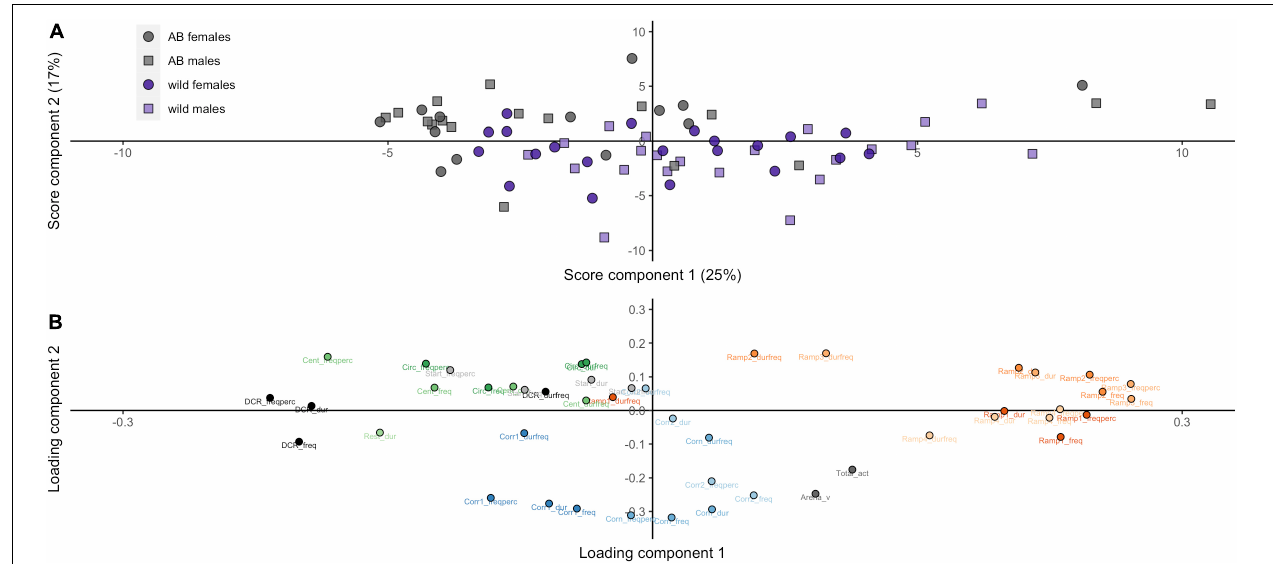
FIGURE 2 | Principal component analysis (PCA) of the behavior from the zMCSF for wild and AB zebrafish (for AB zebrafish, only Run 1 is included here). Scatterplots of (A) individual scores on PC2 and PC1 (score plot) and (B) variable loadings on PC2 and PC1 (loading plot). CENT, center; CIRC, central circle; CORN, corner; CORR, corridor; DCR, dark corner roof; REST, the part of the arena not designated to any other zone; Dur, duration in zone (s); Durfreq, average duration per visit (s); Freq, frequency; Freqperc, frequency divided by the total number of zone entries to all zones (%); V, mean velocity in the arena (cm s − 1 ).